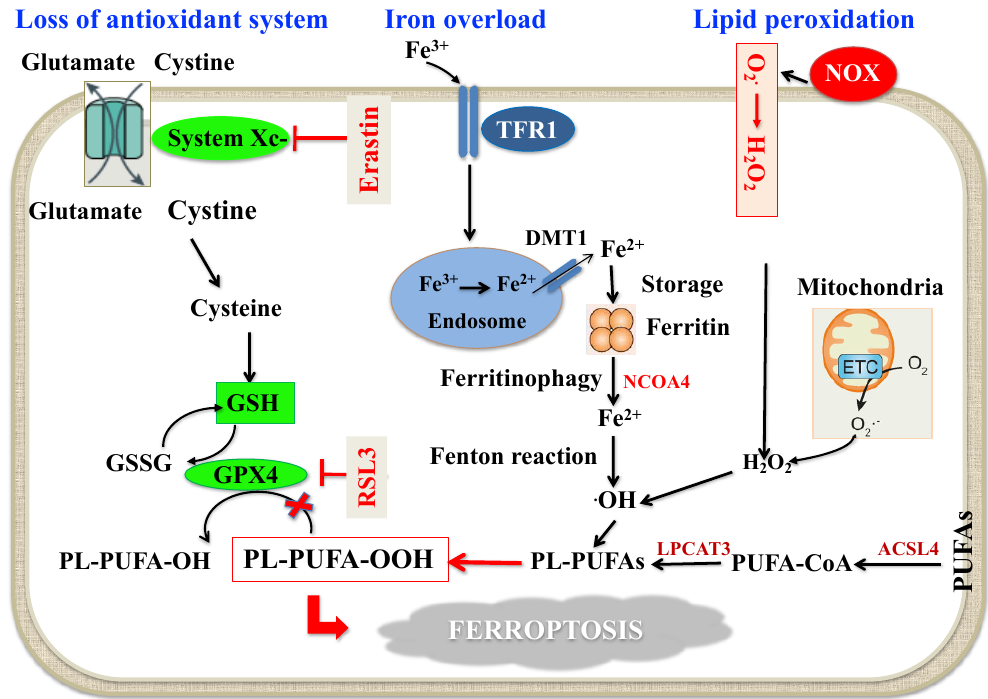
Figure 1. Schematic molecular mechanisms of ferroptosis. Loss of antioxidant system : System Xc- facilitates the cellular uptake of cystine, which is reduced by cystine reductase to cysteine, a key precursor in GSH synthesis. GSH serves as an important reducing cofactor for GPX4 (which catalyzes the reduction of lipid peroxides to their corresponding alcohols) while also forming GSSG. Erastin inhibits the cellular uptake of cystine, thus impairing intracellular GSH synthesis. Depletion of GSH leads to the indirect inactivation of GPX4, and the resulting accumulation of lipid peroxides disrupts membrane integrity resulting in ferroptosis. RSL3 acts by directly inactivating GPX4 and does not interfere with the cellular uptake of cystine or intracellular GSH synthesis. Intracellular iron accumulation : Circulating iron (Fe 3+ ) bound to transferrin enters into cells by TFR1, localizes in endosomes where it is deoxidized to Fe 2+ . Ultimately, Fe 2+ is released into a labile iron pool in the cytoplasm by DMT1, while excess iron is stored in ferritin. Under certain circumstances, there may be degradation of ferritin through autophagy, which is termed as “ferritinophagy”, a phenomenon that triggers an increase in labile iron pool and ·OH via the Fenton reaction. This process requires H 2 O 2 production by activation of NOX, or mitochondria ETC pathways. Lipid peroxidation : The generation of PL-PUFAs by ACSL4 and LPCAT3 have a main role in promoting lipid peroxidation. At the final step of ferroptosis, lipid peroxidation directly or indirectly induces pore formation of cell membrane, thus triggering cell death. Abbreviations: ACSL4: Acyl-Coenzyme A synthetase long-chain family member 4; DMT1: